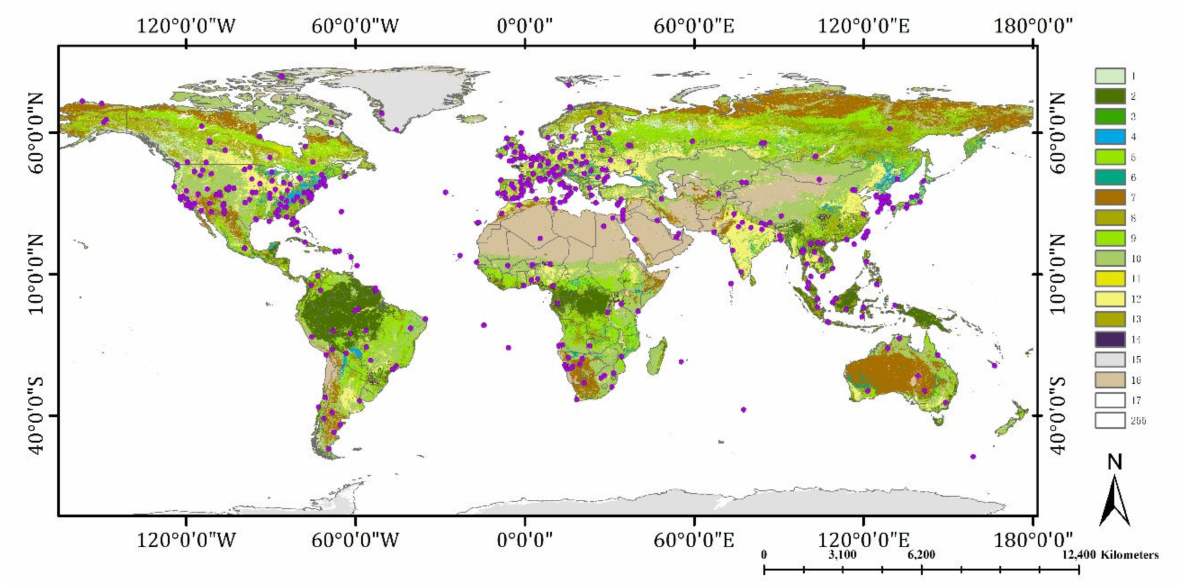
Figure 1. Locations of the global Aerosol Robotic Network (purple dots) monitoring stations that were used for our model development. Land use cover types in 2016 (background colored shading) are marked based on the MODIS land use cover product at a 500 m spatial resolution. Descriptions of the land use classes in the legend are given in Table